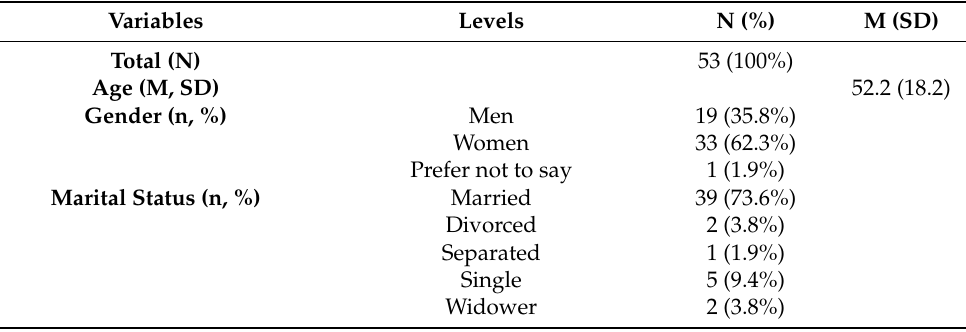
Figure 1. Prisma flow diagram of study participants [30]. Table 2. Socio-demographic information on the participants.